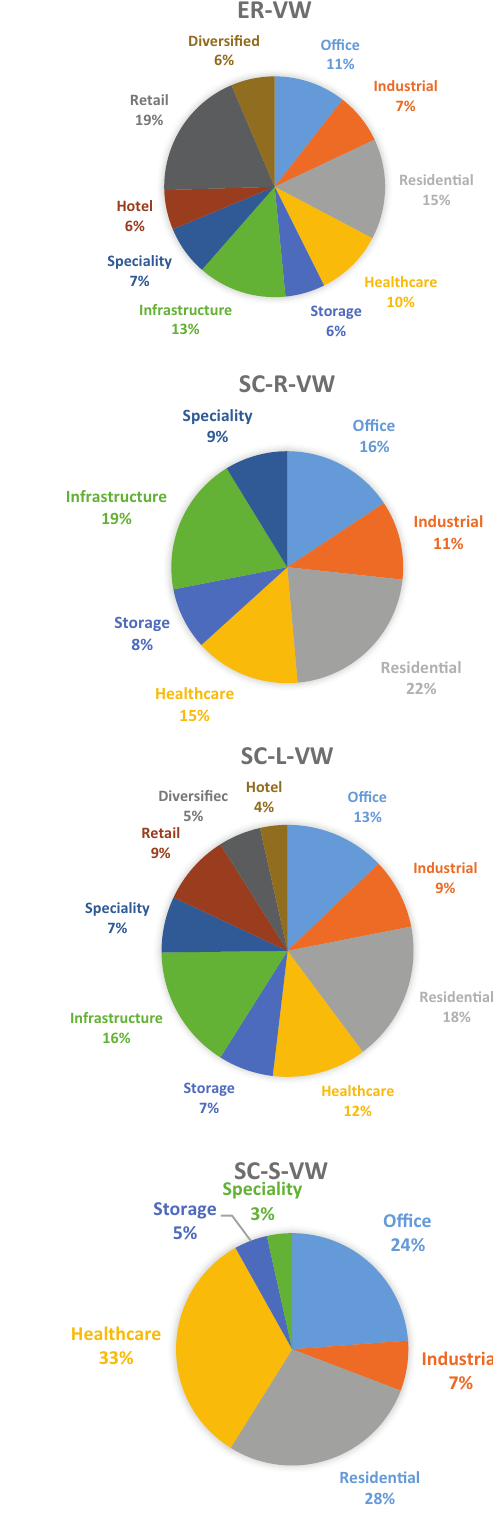
Figure 2. Property type composition of